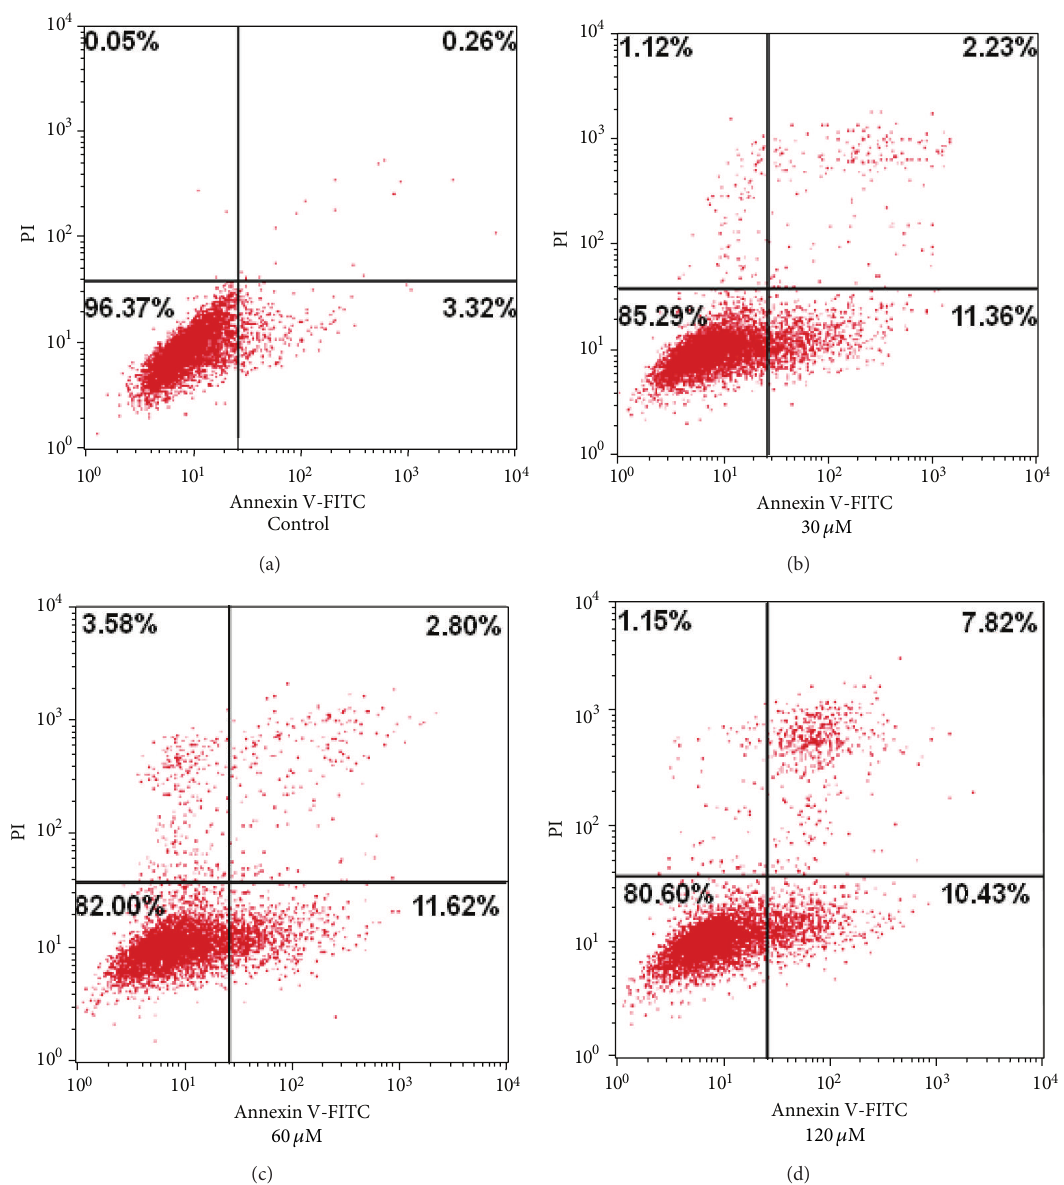
Figure 9: Distribution map of cell apoptosis. BEL-7402 cells were incubated with different concentrations of complex 1 (30, 60, and 120 𝜇 M) for 48h, subjected to Annexin V-FITC/PI staining, analyzed by flow cytometry. 120 𝜇 M of 1 and 2 for 48 h, respectively. The results